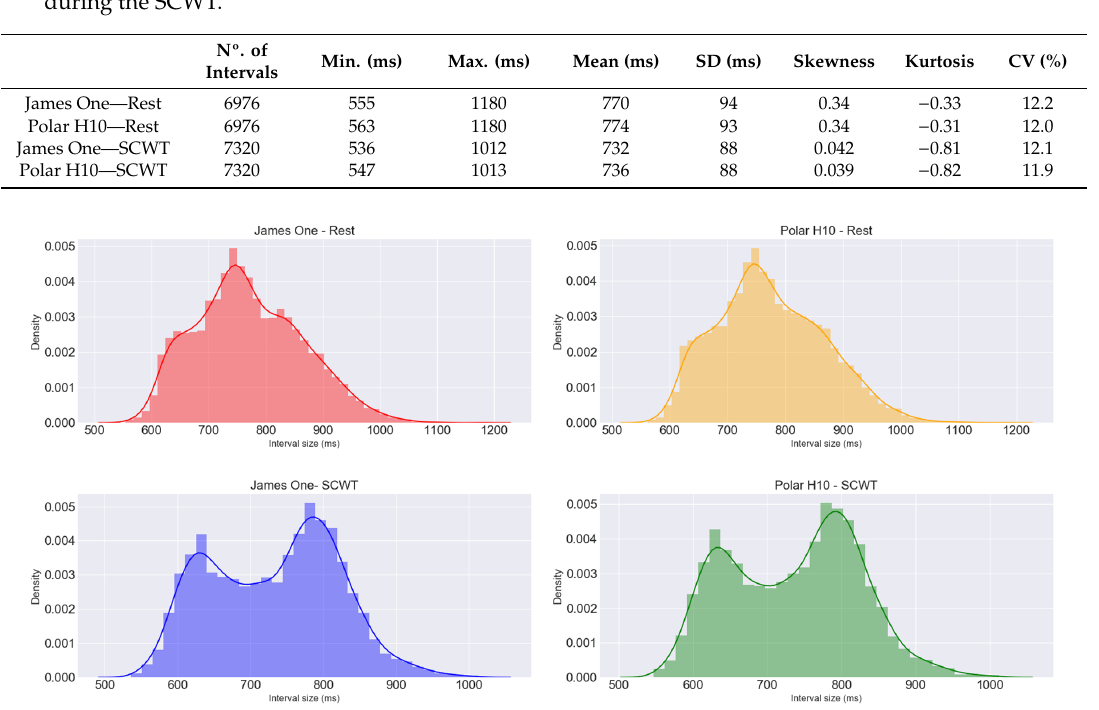
Table 2. Descriptive statistics of the intervals obtained from the James One and Polar H10 at rest and during the SCWT.